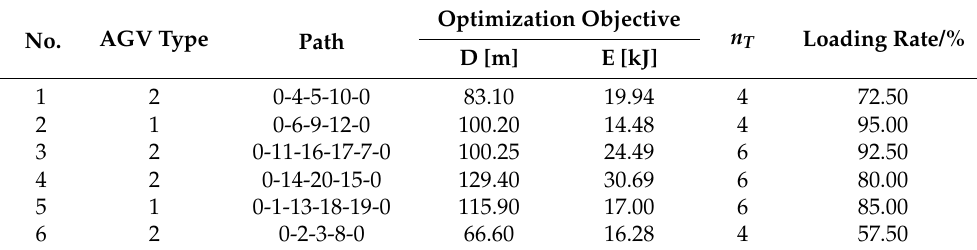
Table 12. Feasible paths for using heterogeneous multitype AGV fleet transportation. No. Path